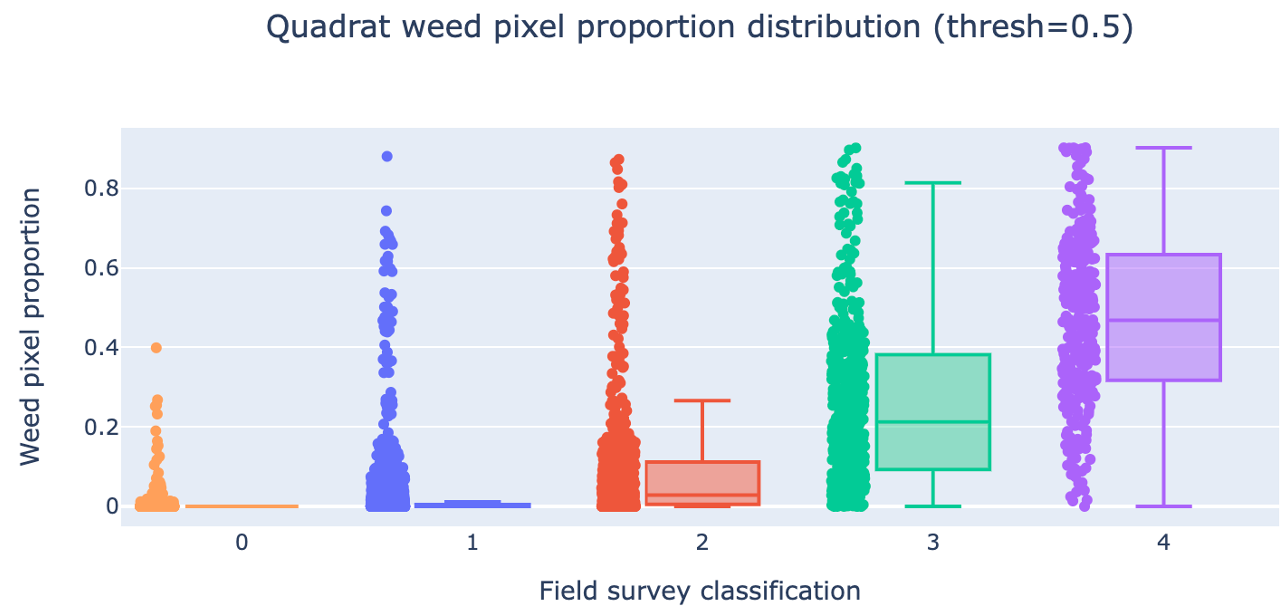
Figure 3. Quadrats weed pixel proportion distribution, as identified by the deep learning model (e.g., using 0.5 as a probability threshold to identify weed pixels) and compared to black-grass field survey data (0: none (N = 920); 1: low (N = 2848); 2: medium (N = 606); 3: high (N = 470); 4: very high (N =